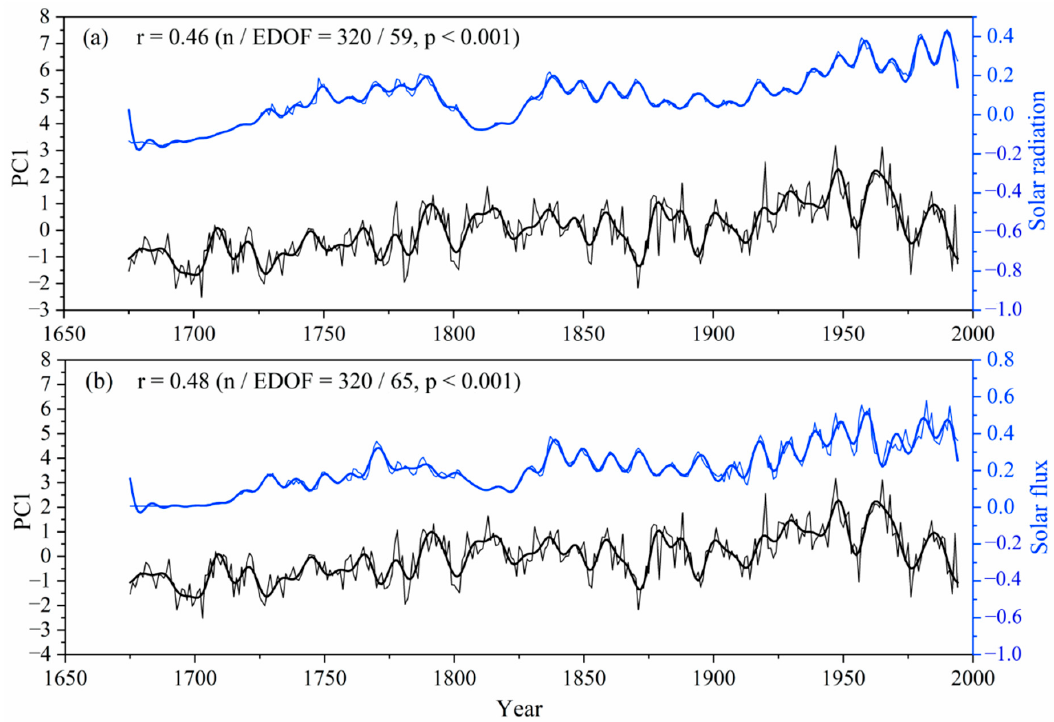
Figure 12. Correlations of the PCA series with ( a ) solar radiation and ( b ) solar flux.